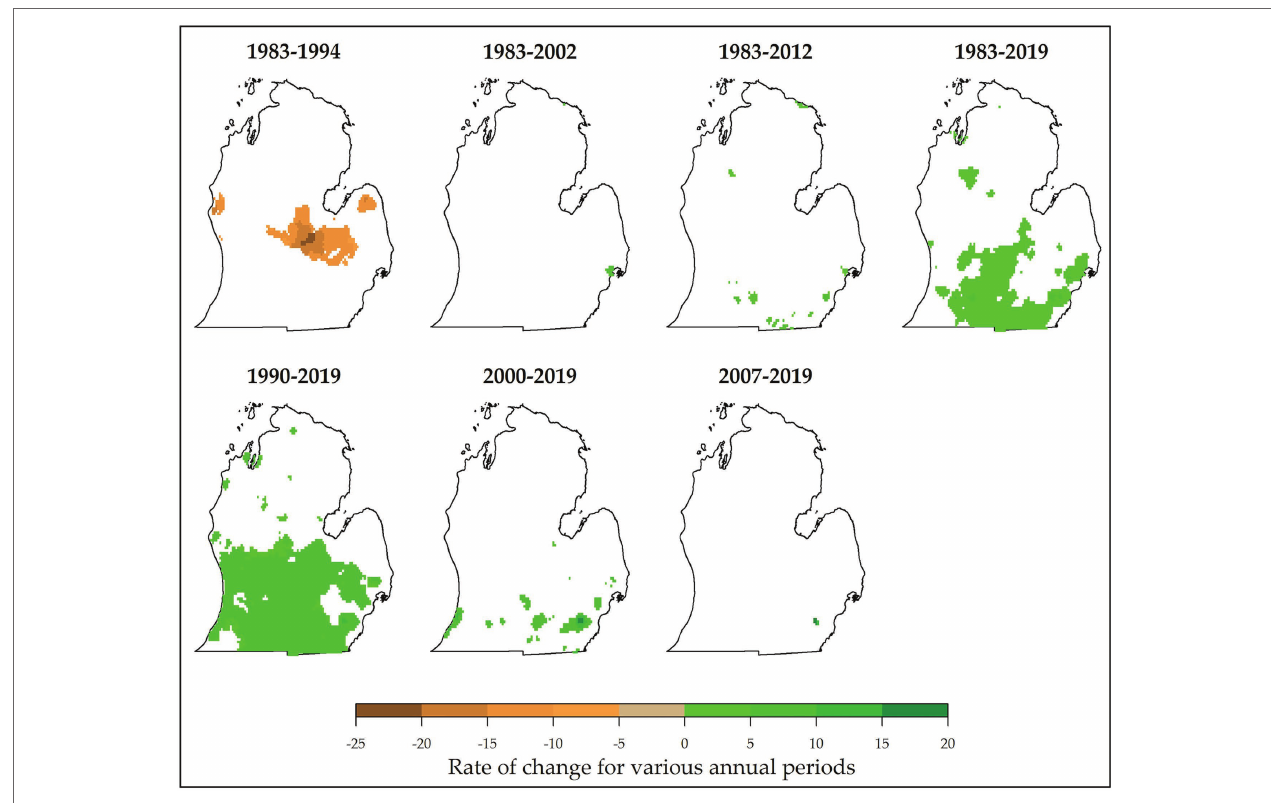
FIGURE 5 | Magnitude of change in the annual numbers of growing degree days (GDDs; accumulated days per year) for different study periods (at α = 0.10 level). Locations of persistently changed GDDs are shown. Highest proportions of changed area were found in 1990–2019 and 1983–2019. However, greatest changes in GDDs were observed in 1983–1994 ( − change) and 2000–2019 (+ change). For reference, typical GDDs in Lower Peninsula MI range from 750 to 2040 accumulated days per year ( Table 1 ).